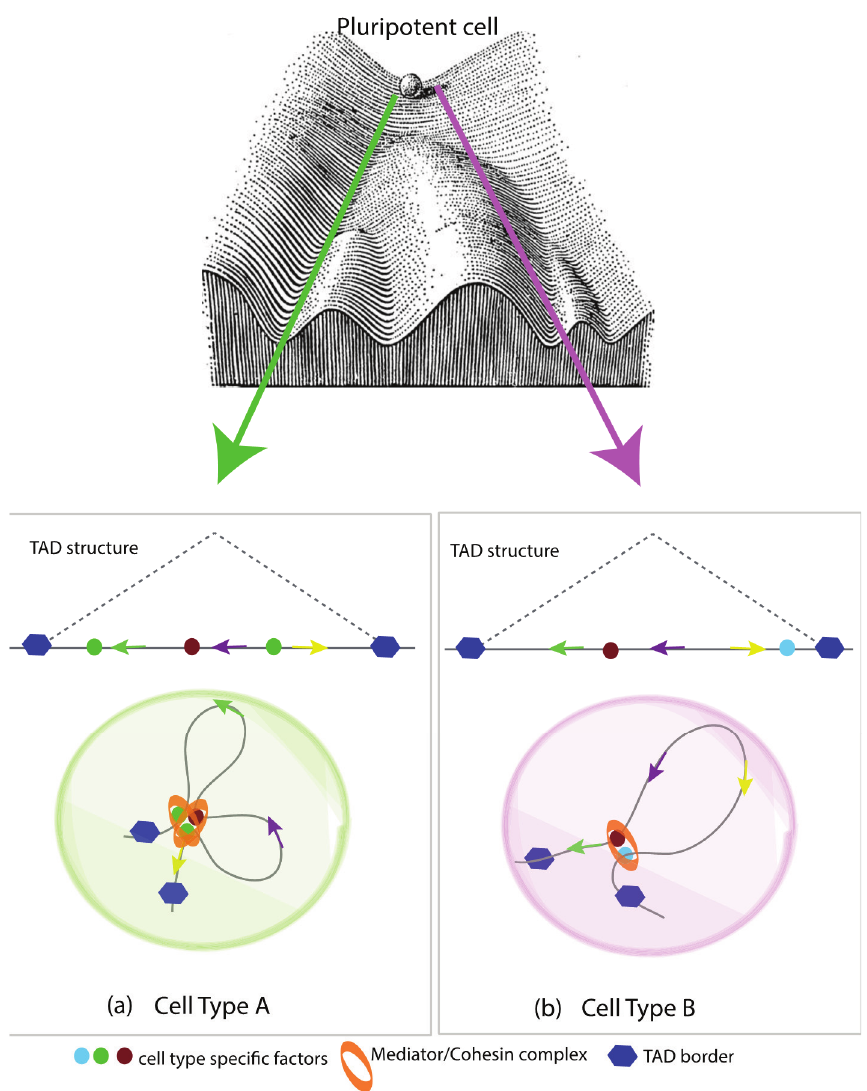
Figure 4. Cell-type-specific genome wiring at the kilobase level. This schematic shows chromatin organization defining the cell type specificity for pluripotent cell along the Waddington’s epigenetic landscape. ( a ) Intra-TAD looping in Cell type A, mediated by the Mediator/Cohesin complex, is instrumental in specifying cell type chromatin folding; ( b ) Despite the overall TAD structure remaining consistent, it is the kilobase-scale interactions in Cell type B that assign the transcriptional program of the cell leading to its lineage